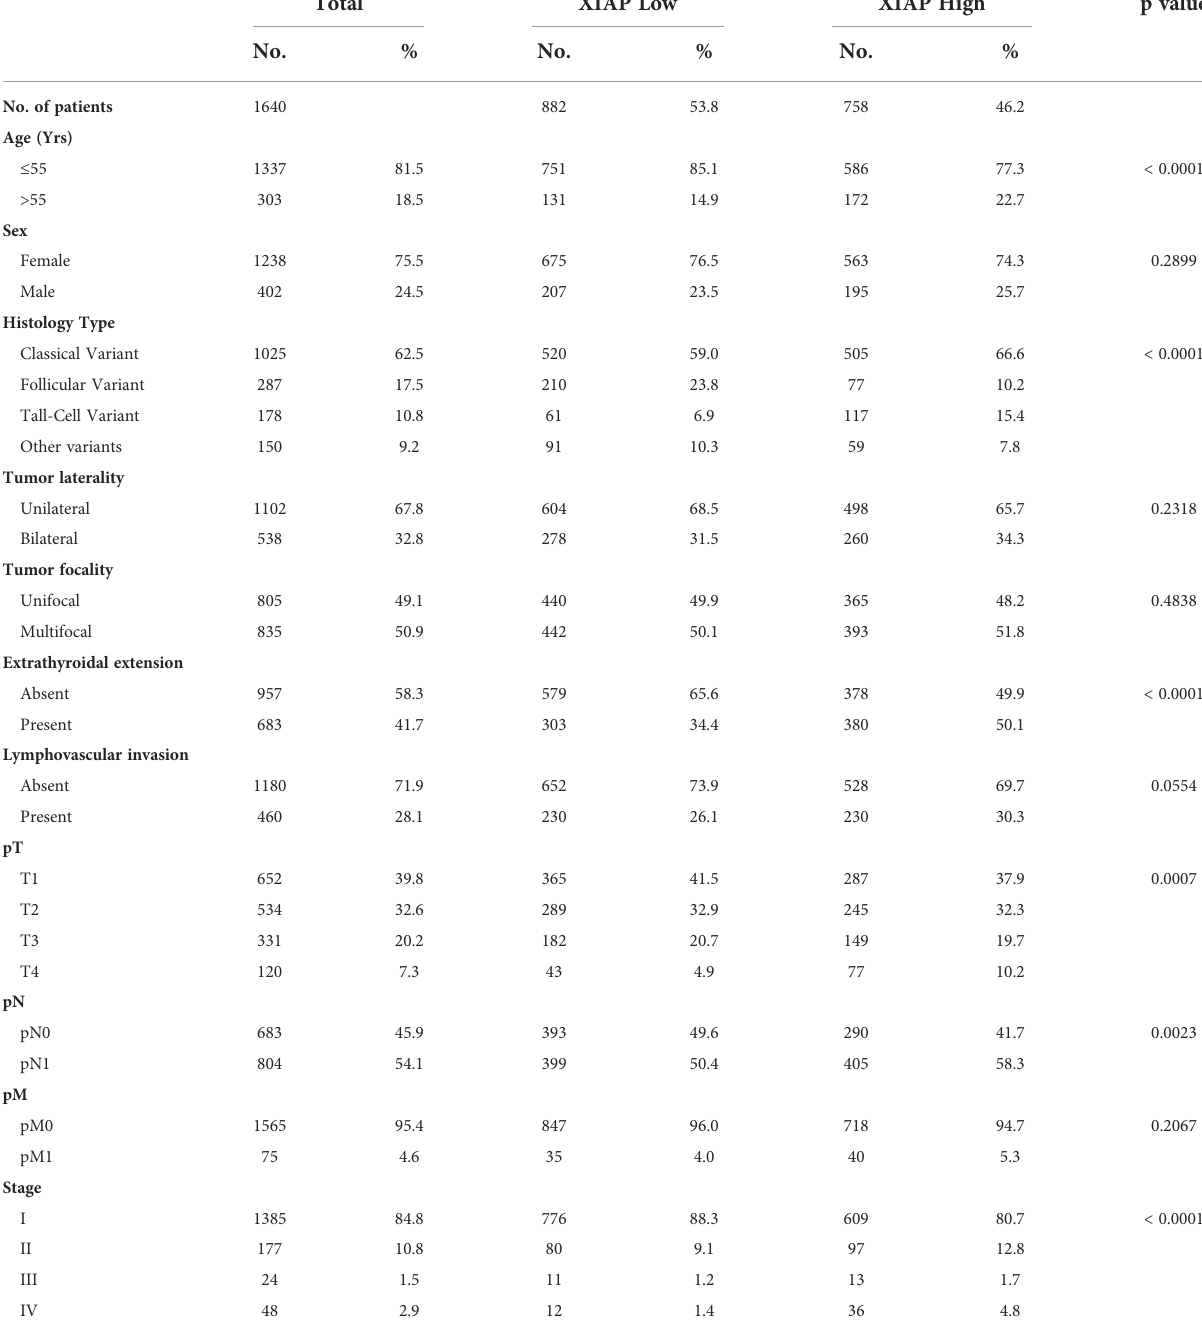
TABLE 3 Clinico-pathologic associations of XIAP expression in papillary thyroid carcinoma. Total XIAP Low XIAP